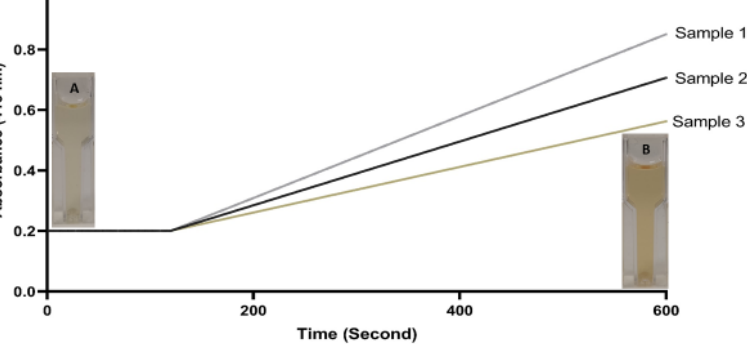
Figure 2. The reaction kinetics of serum samples with different activities. A (sample 2), serum + reagent 1 (buffer solution); B (sample 2), serum + reagent 1 + reagent 2 (substrate solution).